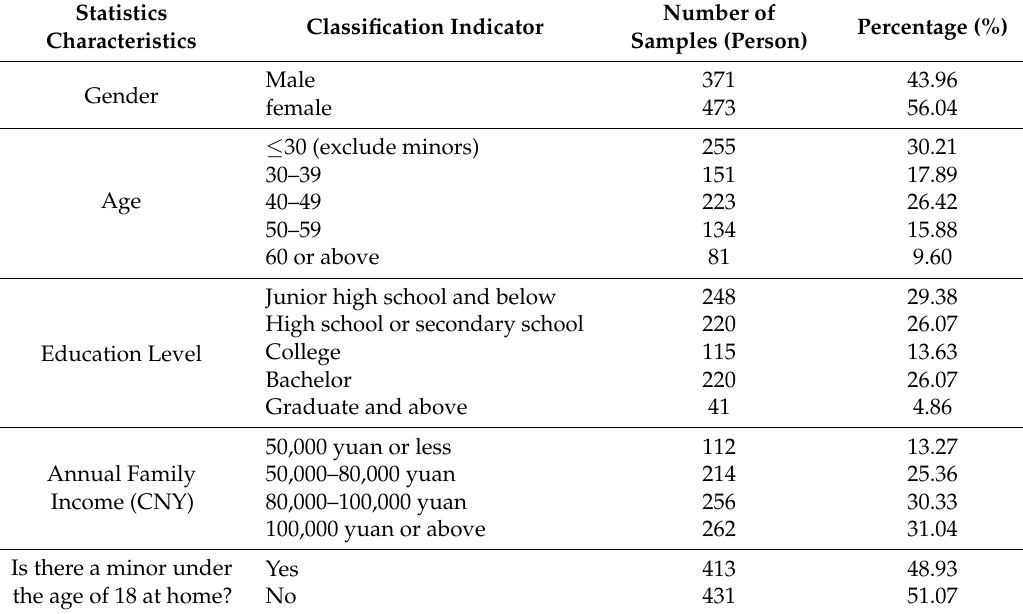
Table 2. The personal characteristics statistics of the sample